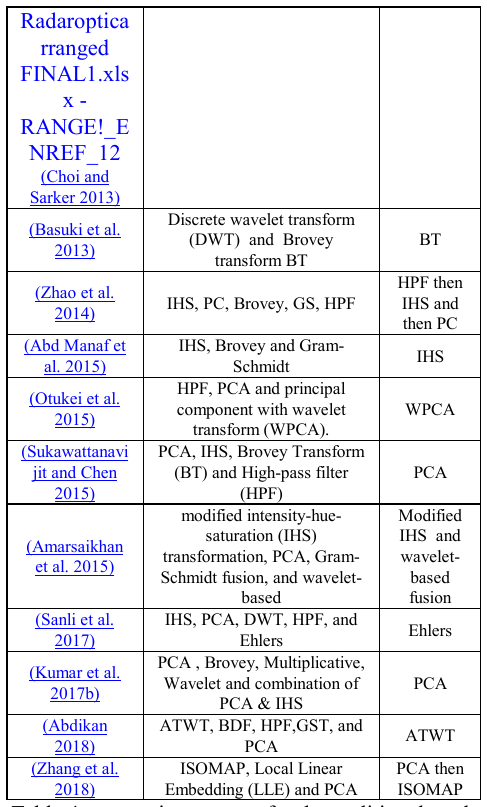
Table 4: comparison papers for the traditional methods